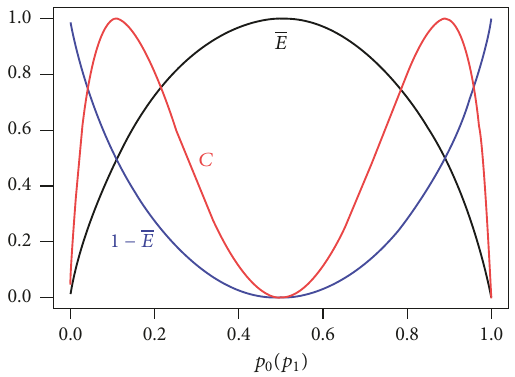
Figure 2: Relationship between change 𝐸 , regularity 1 − 𝐸 , and complexity 𝐶 in RBNs